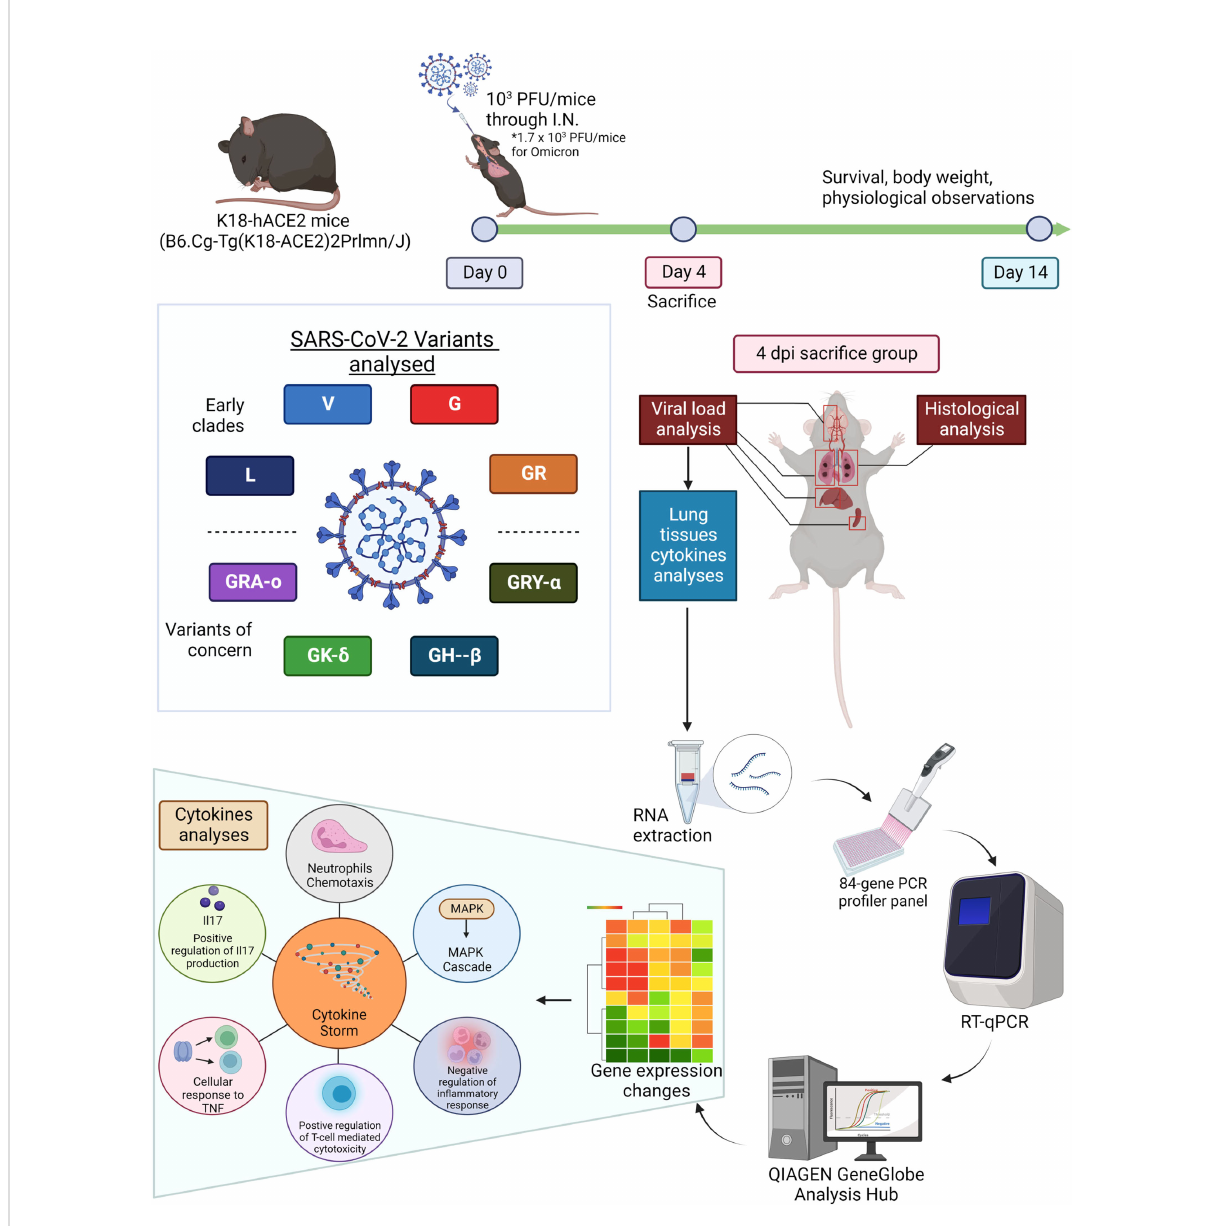
FIGURE 1 Summarized methodology of characterization of eight viral iterations (ancestral to Omicron) of SARS-CoV-2. K18-hACE2 mice were infected the eight different SARS-CoV-2 viruses and divided into survival group and 4 dpi group (sacri fi ced 4 days post infection). The survival group were used for assessment of survival and physiological assessment. The 4 dpi group were sacri fi ced and have organs harvested for virologic, histologic and molecular pro fi ling analysis (cytokine and chemokine gene expressions). Figure created with